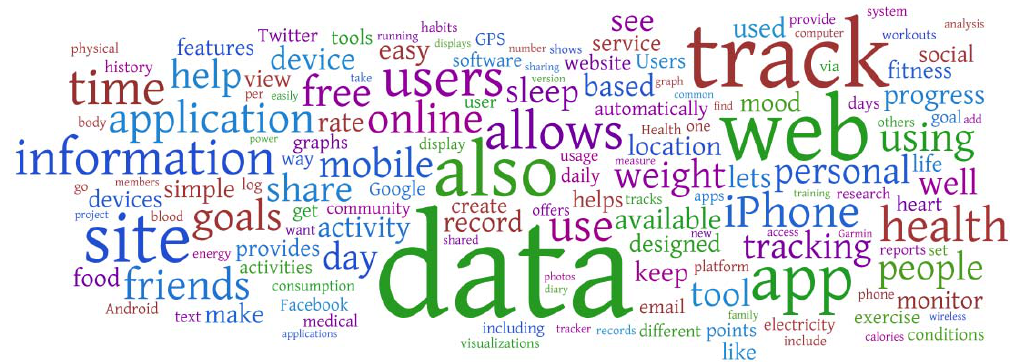
Figure 3. Visualization of Keywords Used in Quantified Tracking Device Descriptions.